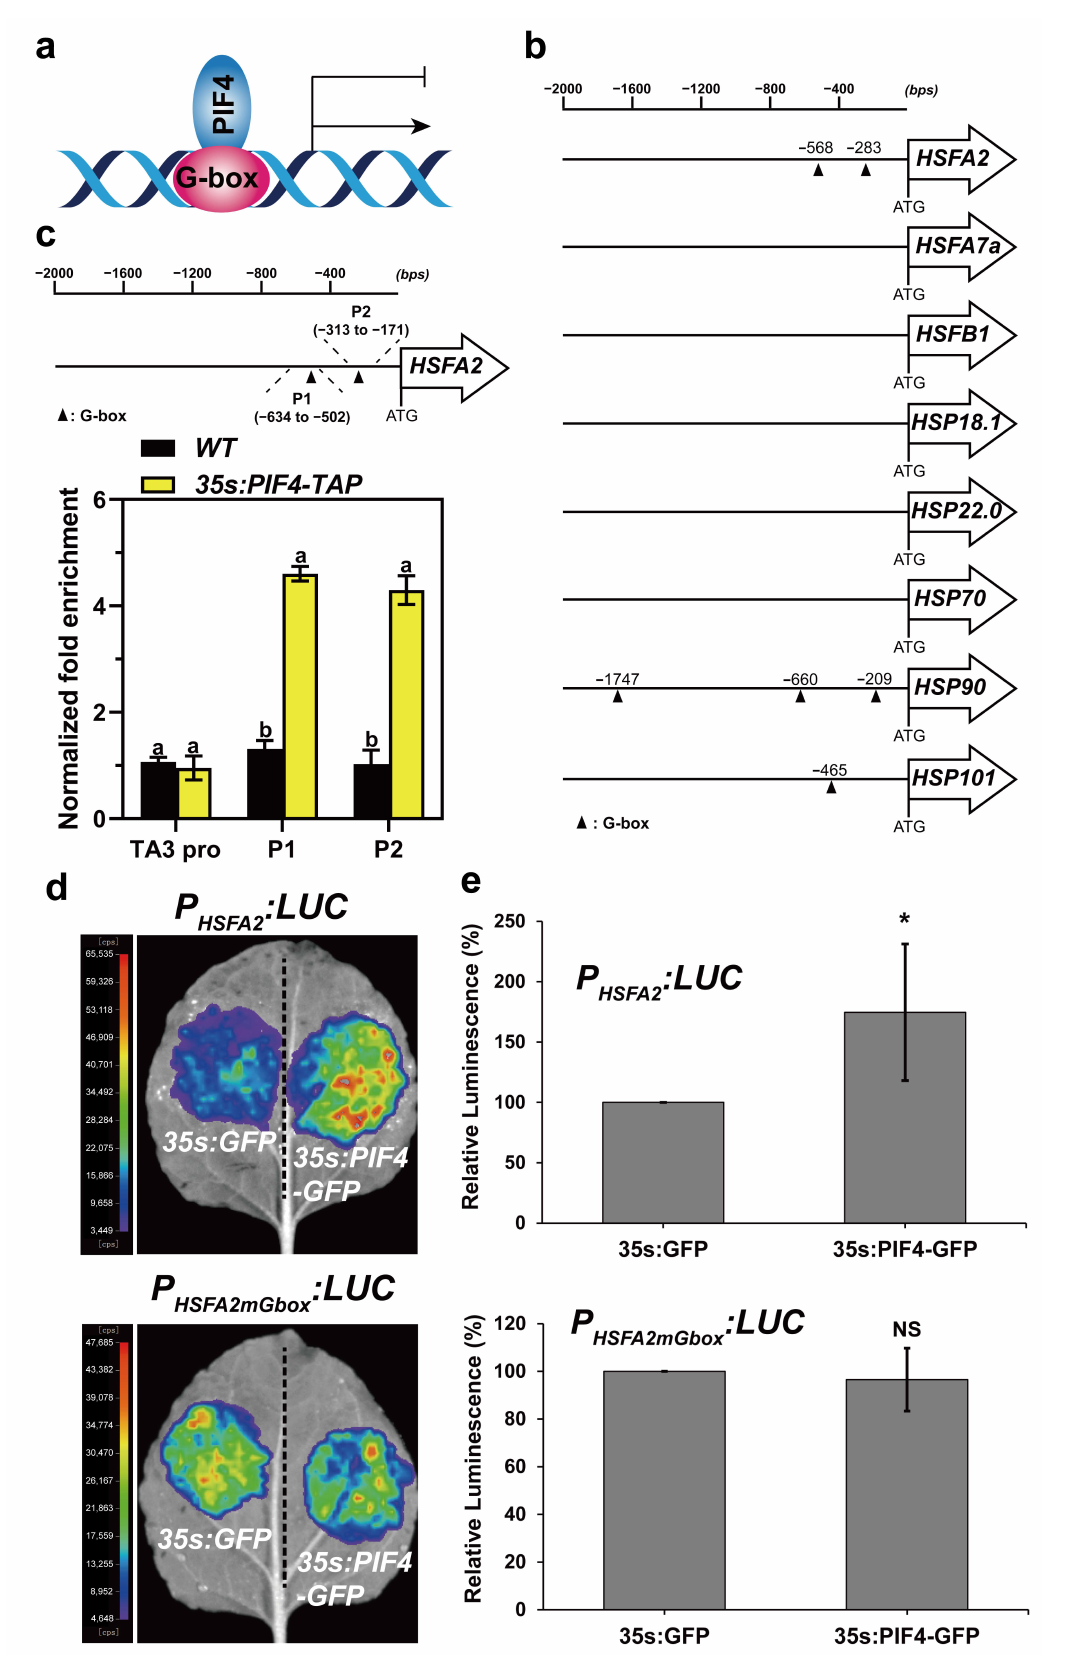
Figure 8. PIF4 directly binds to the G-box motifs in the HSFA2 promoter. ( a ) PIF4 directly binds to the G-box motif of gene promoters to activate or repress their expression. ( b ) Schematic representation